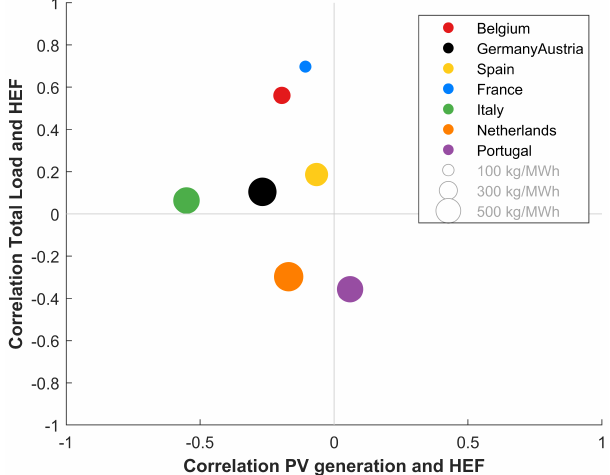
Figure 4. The y-axis depicts the correlation between a Country’s electricity load and its HEF con , the x-axis depicts the correlation between a country’s PV-generated electricity and its HEF con